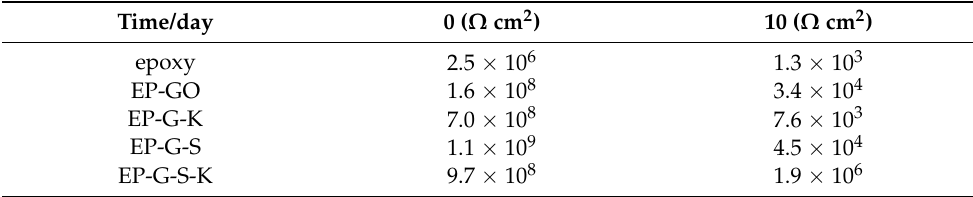
Figure 7. ( a ) EIS spectra and ( b ) Bode spectra of different coatings. ( c ) EIS spectra and ( d ) Bode spectra of different coatings after 10 days. ( e ) Scheme illustration of equivalent electrical circuit models for all the samples. Table 2. The low-frequency range impedance |Z| 0.01Hz of epoxy, EP-GO, EP-G-K, EP-G-S, and EP-G-S-K before and after 10 days of